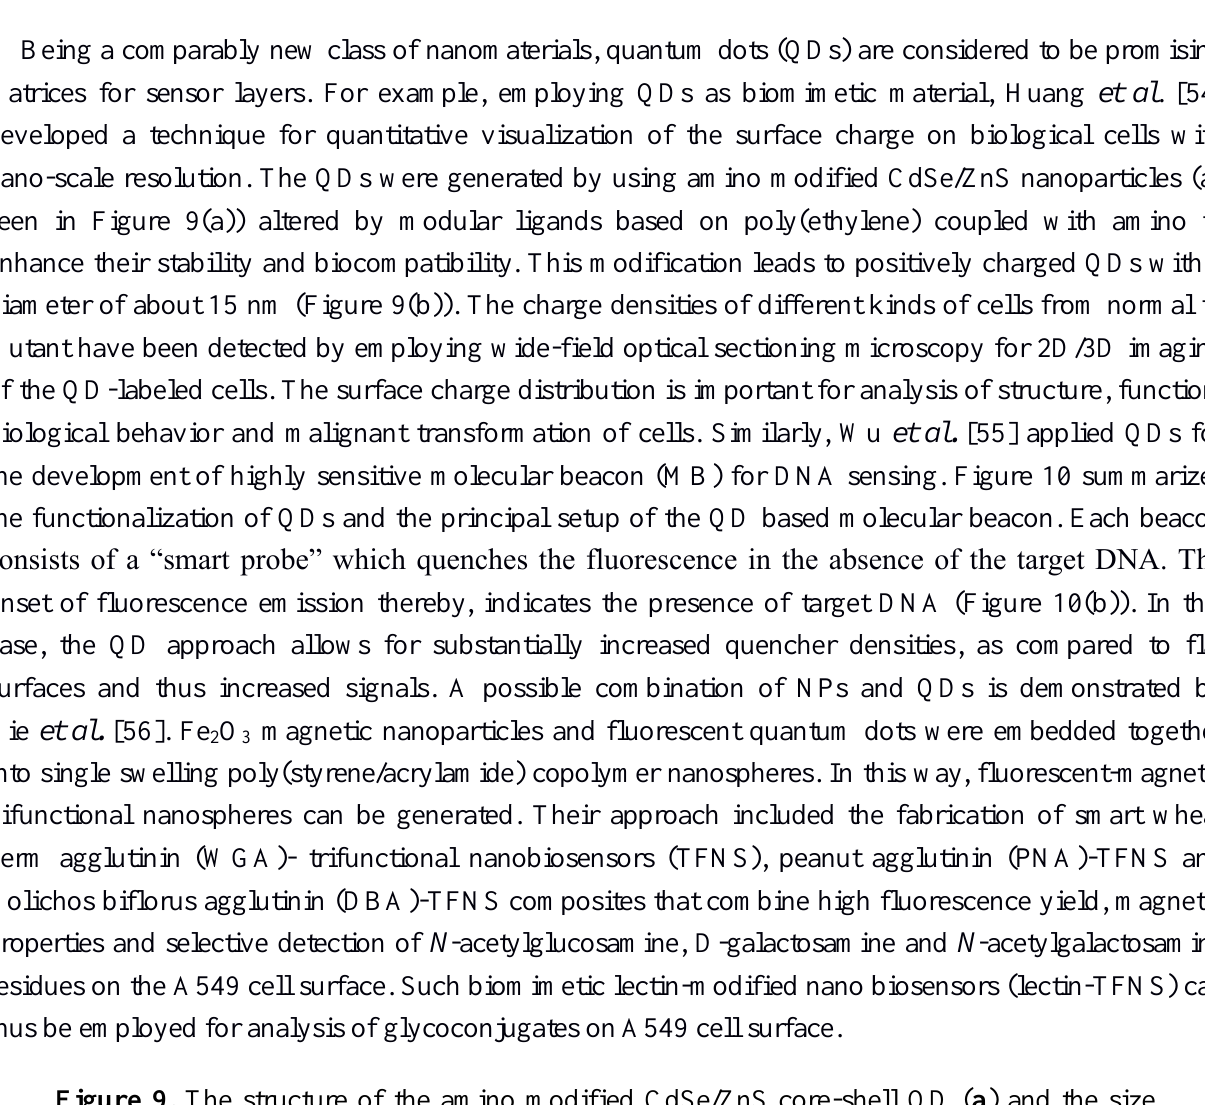
Figure 9. The structure of the amino modified CdSe/ZnS core-shell QD ( a ) and the size distribution of the QDs ( b ) in the aqueous environment of living cells. The averaged diameter of the QD is 15.0 ± 0.8 nm. Reprinted with permission from [54], © 2011